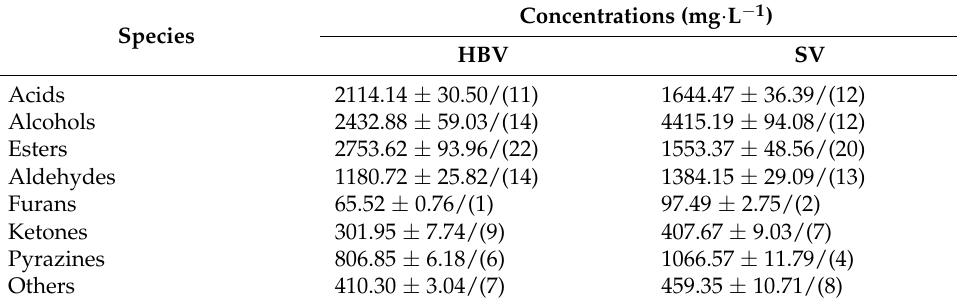
Table 4. VFCs classification in aged HBV and